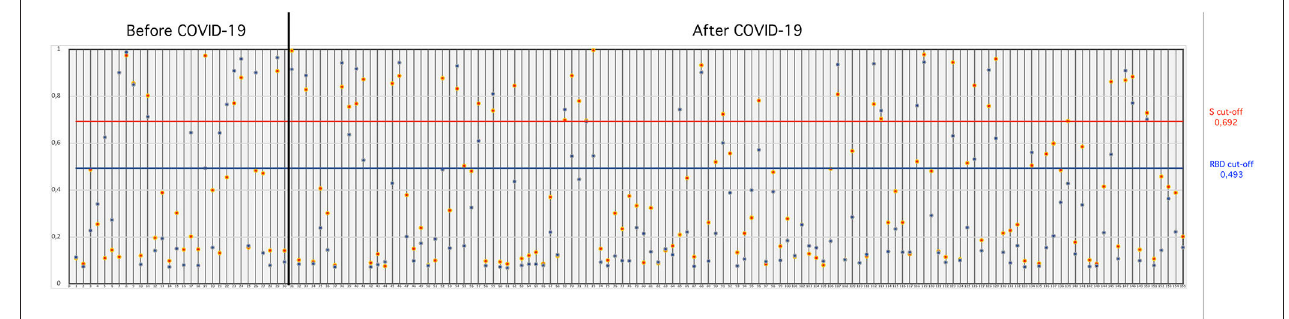
TABLE 1 | Cut-off values and number of positive and negative cat sera as determined by the S- and RBD-ELISA. Cutoff value Positive Negative Positive sera taken Positive sera taken (optical density) “before COVID-19” “during COVID-19” S-ELISA 0.692 41 114 7 34 RBD-ELISA 0.493 44 111 12 32 6 28 5 6